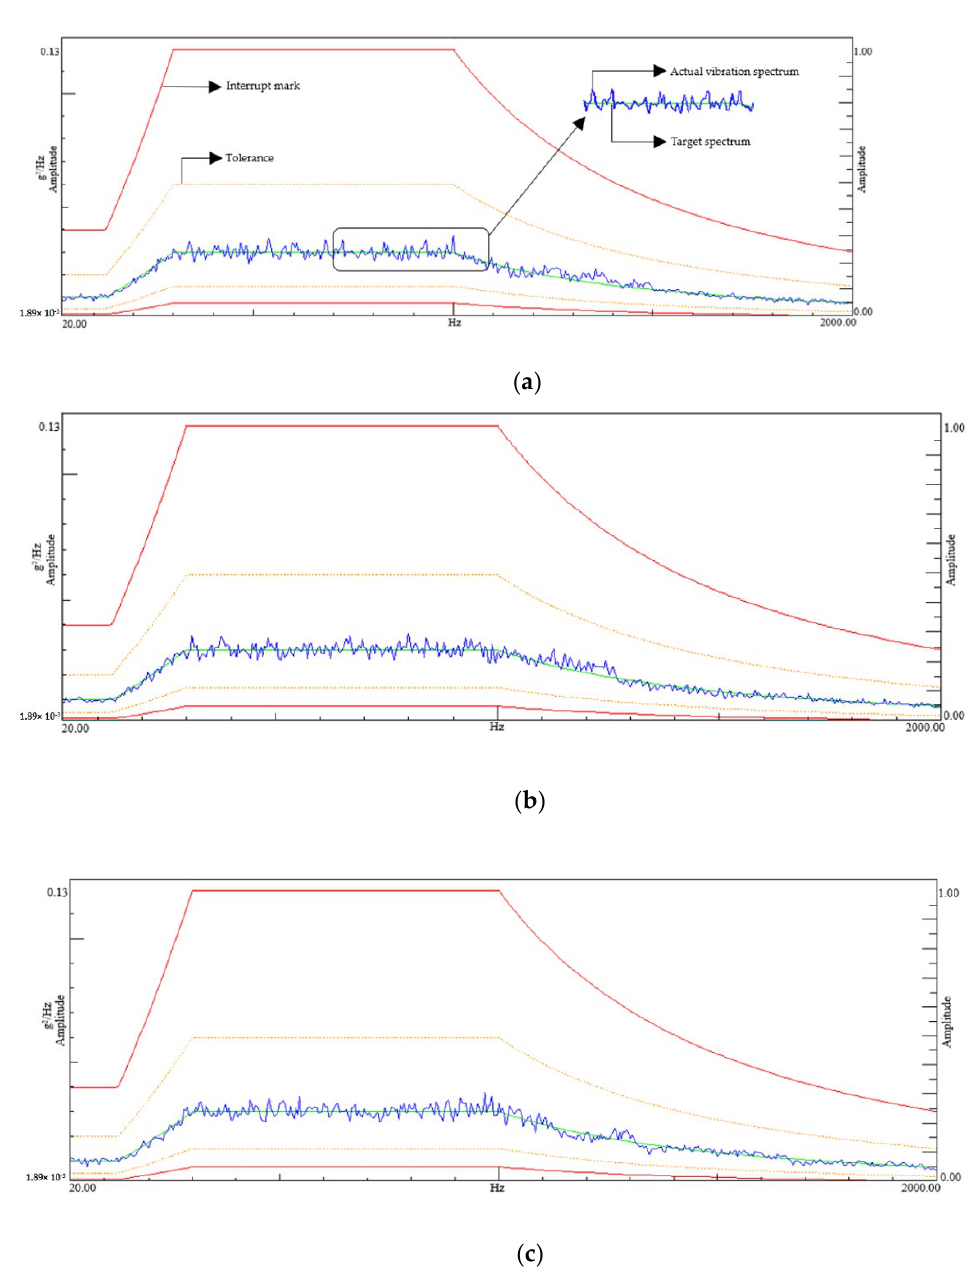
Figure 15. Different direction random vibration test control. ( a ) X direction; ( b ) Y direction; ( c ) Z direction.